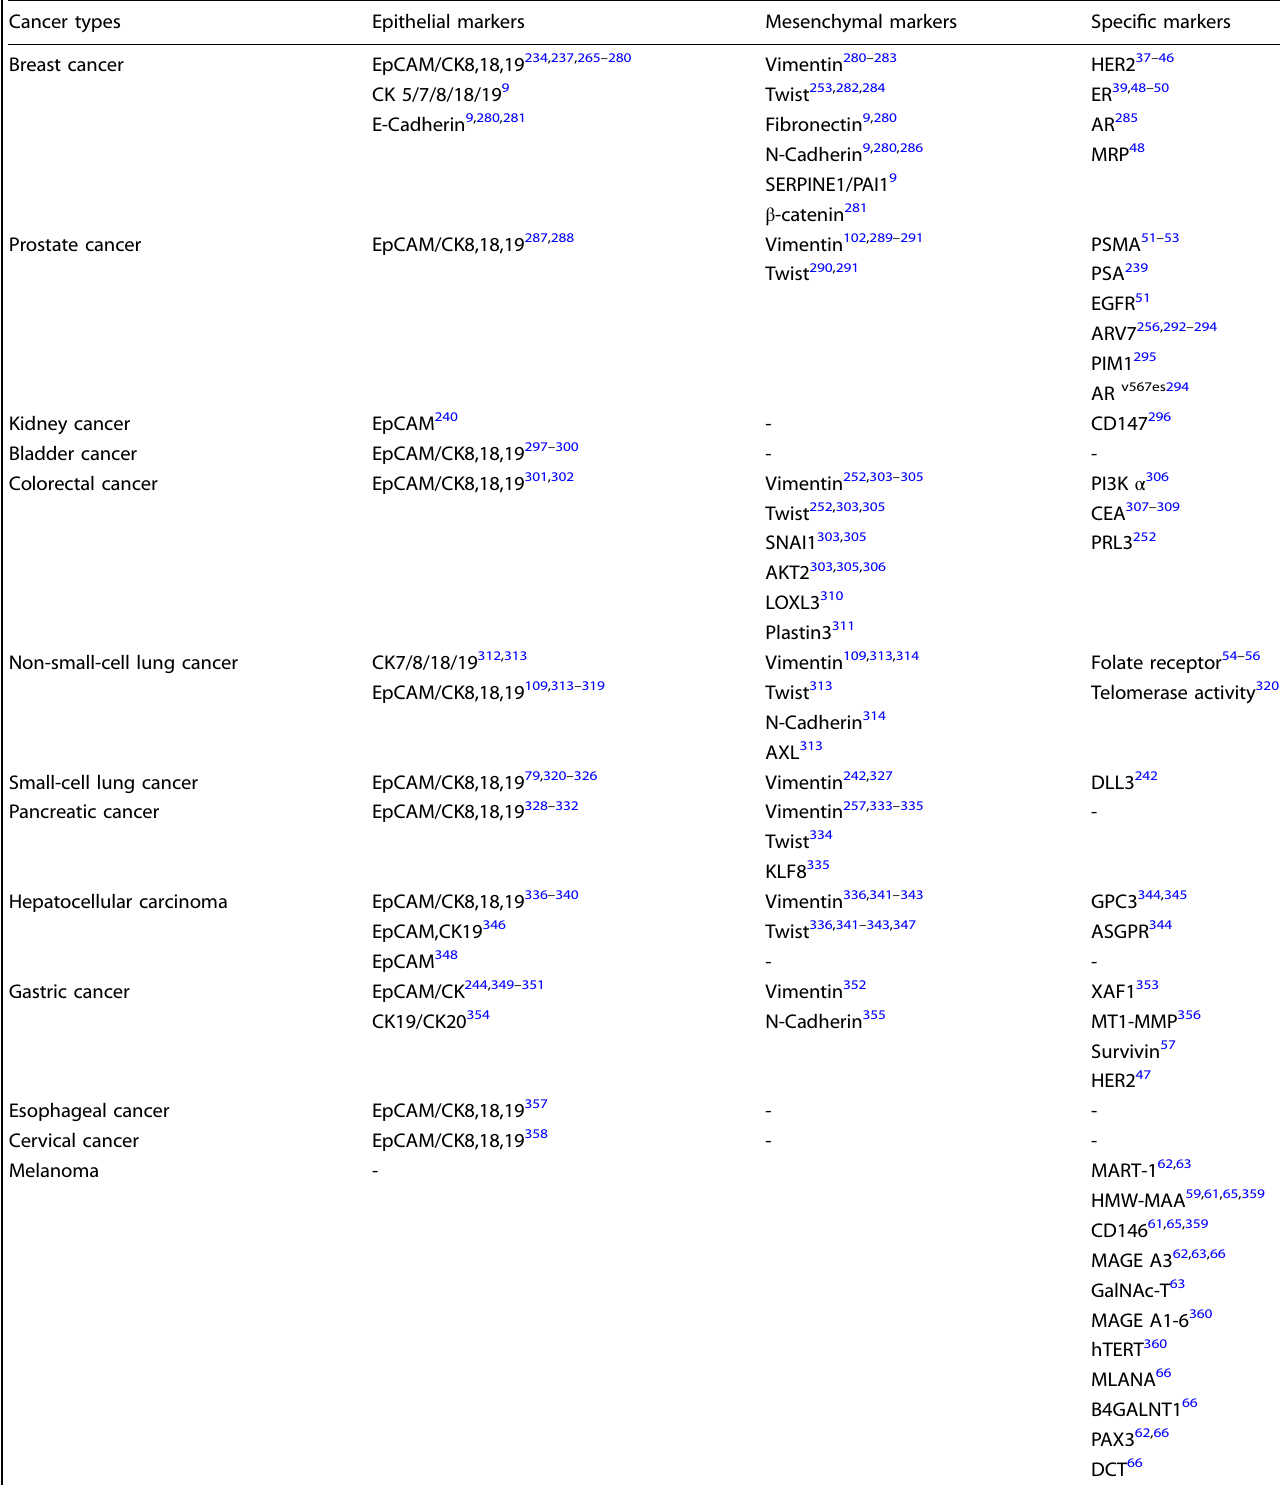
Table 1. Molecular markers used to identify CTCs Cancer